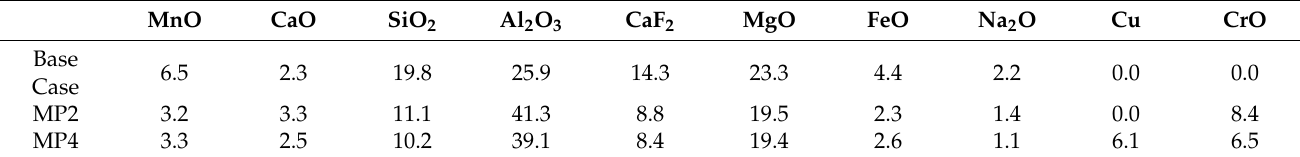
Table 5. Post-weld slag compositions (mass%)